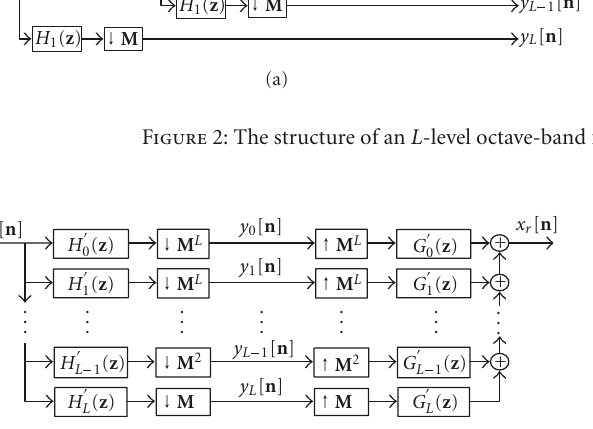
Figure 3: The equivalent nonuniform filter bank associated with the L -level octave-band filter bank.